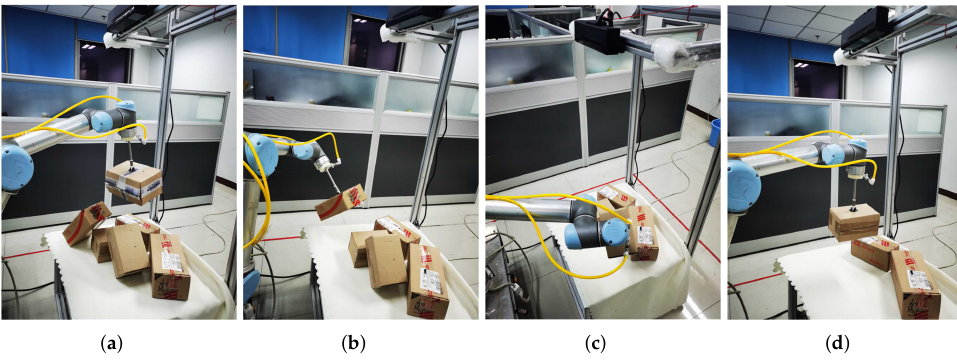
Figure 10. The sorting experiment for stacked parcels. ( a ) Sorting first parcel ( b ) Sorting second parcel ( c ) Sorting third parcel ( d ) Sorting fourth